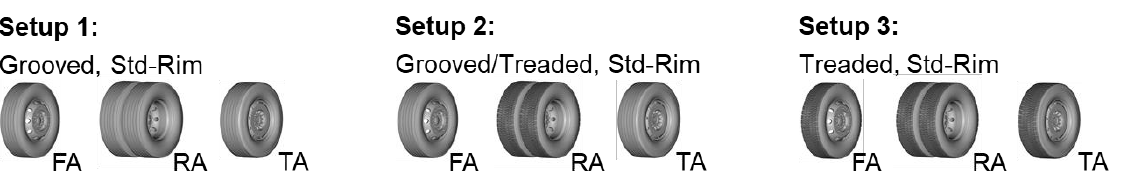
Figure 11. Flow field comparison: CFD results on three different planes oriented normal to the ground plane for the front wheel.